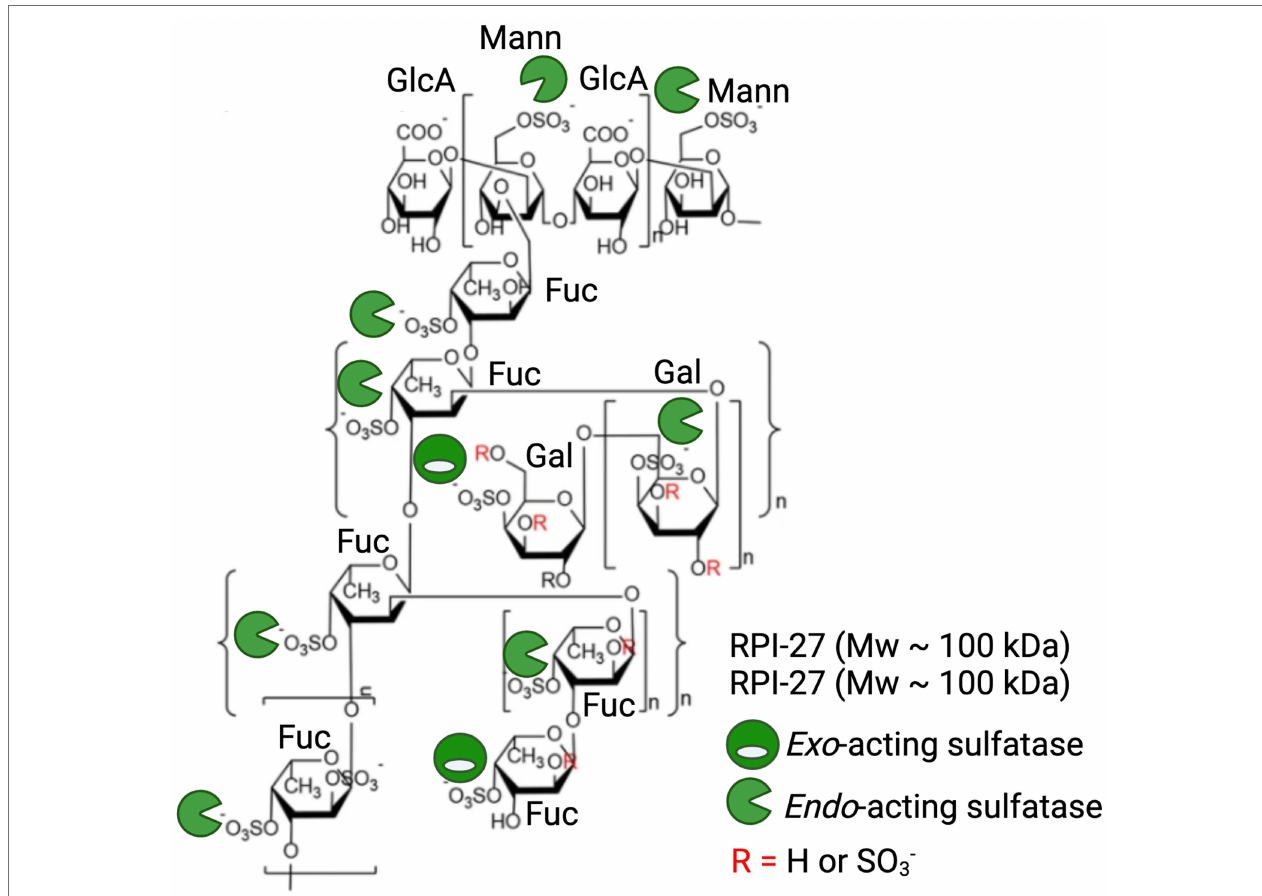
FIGURE 6 | Application of marine polysaccharide sulfatases to enhance anti-viral activity of the fucoidan polysaccharides RPI-27 and RPI-28. Oligomeric chemical structure adapted from Kwon et al. (2020) and labelled with a combination of potential endo -acting and exo -acting sulfatases to specifically tailor the sulphation pattern of RPI-27 and